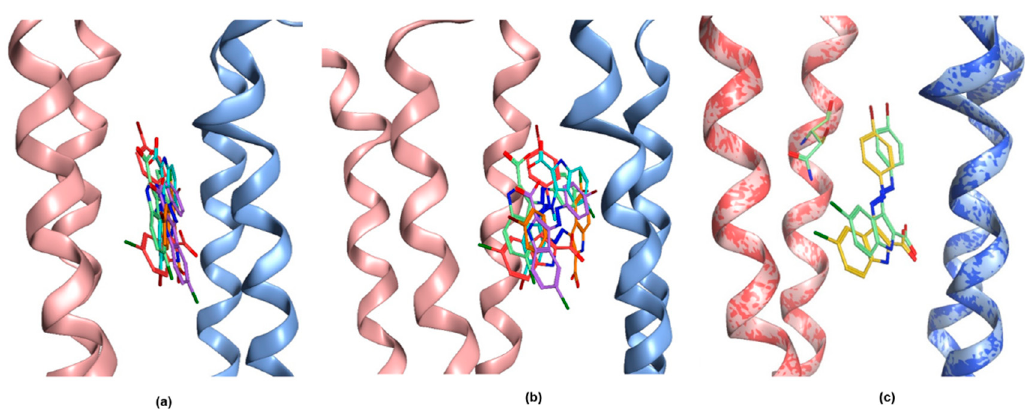
Figure A4. Different binding poses of MTI163 in the N265S mutant. There is no ligand bound structure with the β 1 subunit, thus 6HUP was point mutated for the docking. In this case, five docking poses were found in the top 20 of GoldScore and ChemScore. ( a ) Front view; ( b ) Side view; ( c ) Comparison between the pose displayed in Figure 5 and the most similar pose observed in the N265S mutant. The two bound complexes are superposed (reflected by the two-colored ribbon rendering), the 6HUP (wild type β 3) pose and N265 are rendered as light green sticks, the S265 and the corresponding MTI163 pose are rendered as yellow sticks.